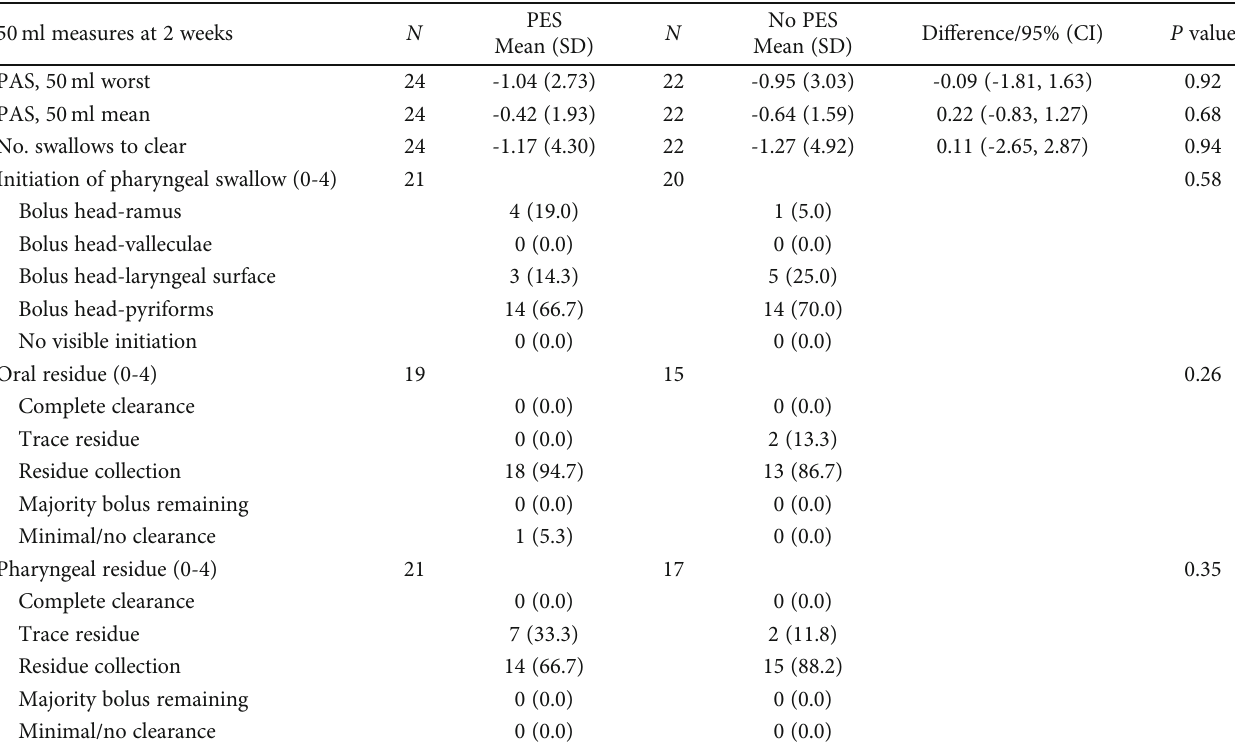
Table 5: Comparison of PAS, timing, and clearance measures for 50ml worst swallow, by change score from baseline to two weeks, using Independent Samples T -Test (continuous variables) and Mann – Whitney U Test (ordinal